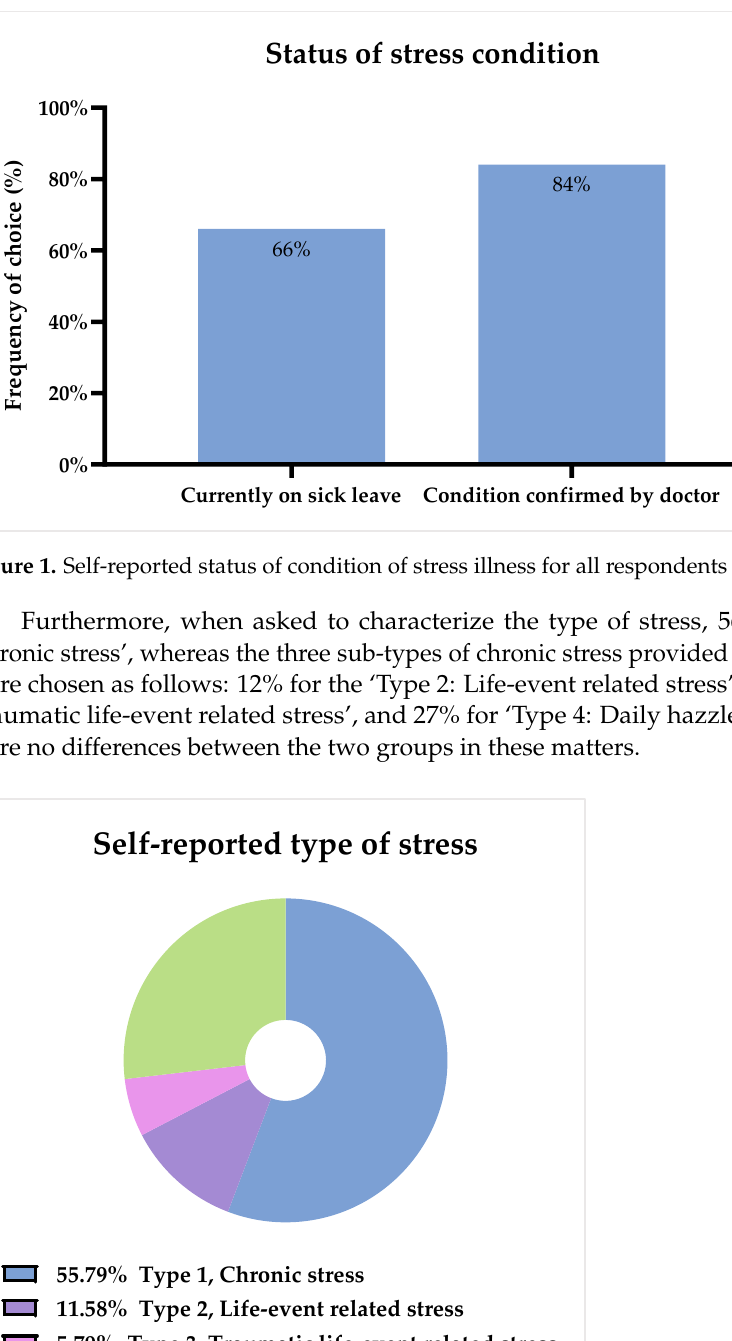
Figure 2. Self-reported type of stress for all respondents ( n = 190).